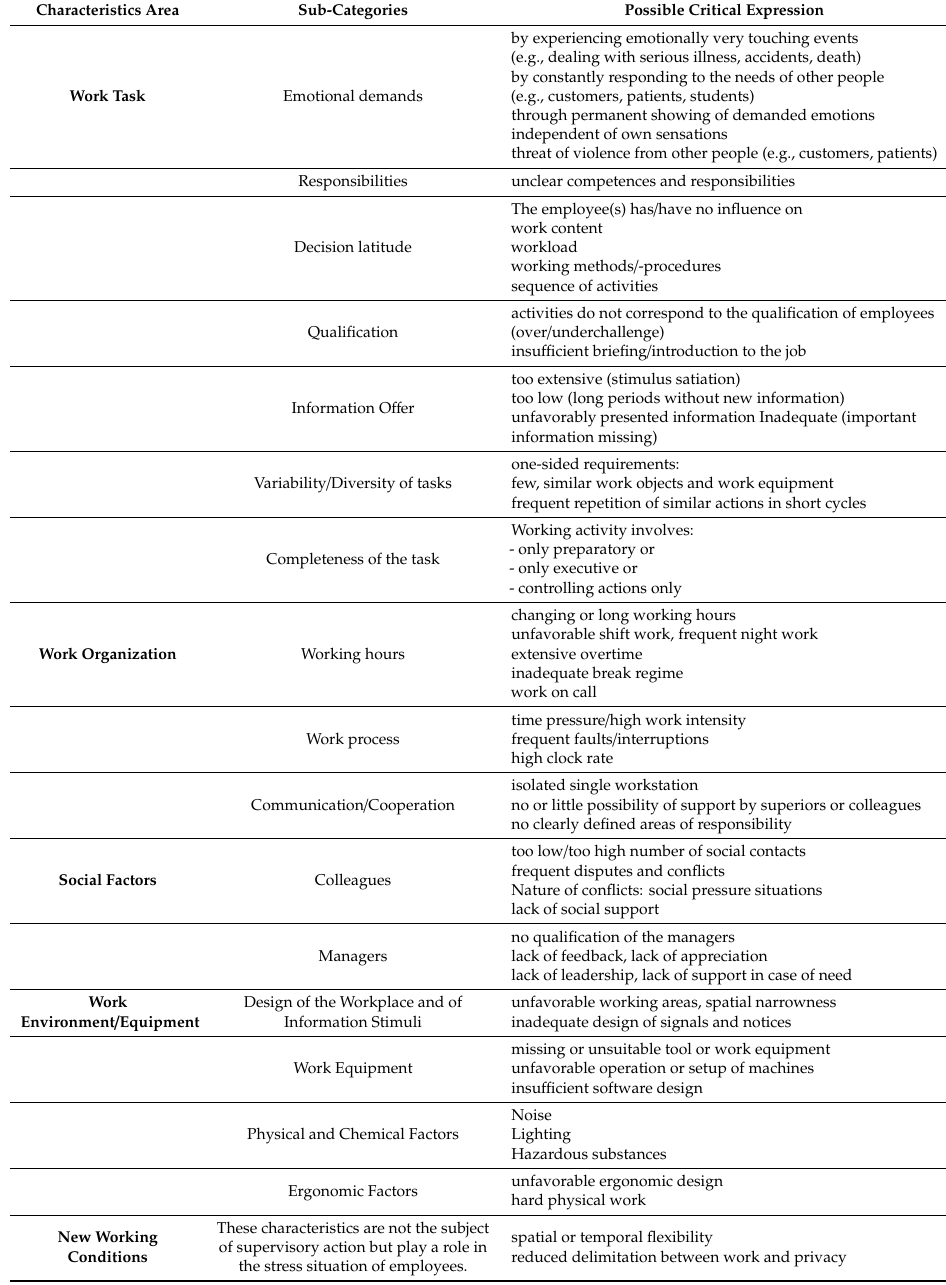
Table A1. Category system for interview